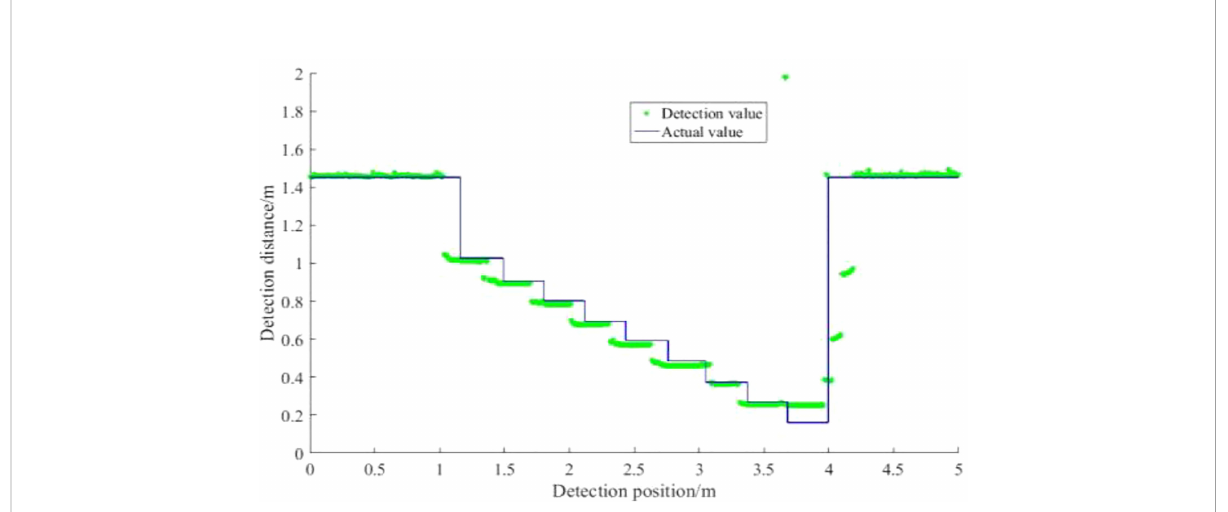
FIGURE 12 Calibration curve of ultrasonic sensor. The comparison between the detection value of the ultrasonic sensor and the actual value in the quasi- static condition shows that the detection has high